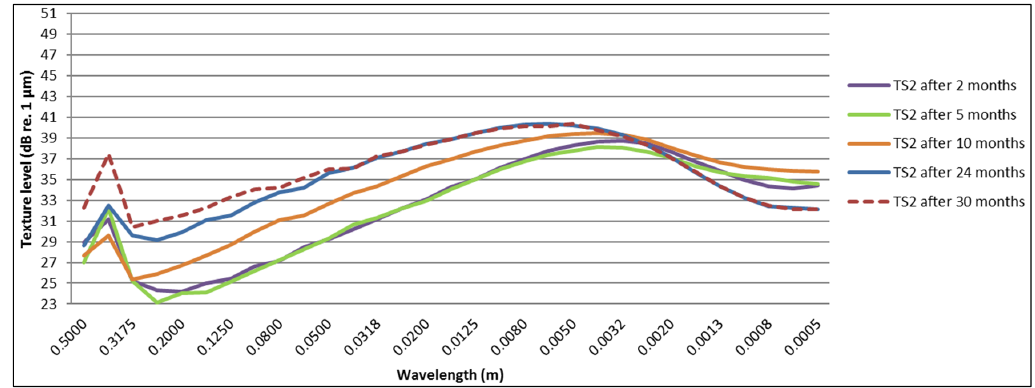
Figure 17. Change in texture spectra over a period of 30 months for Test Section 2.